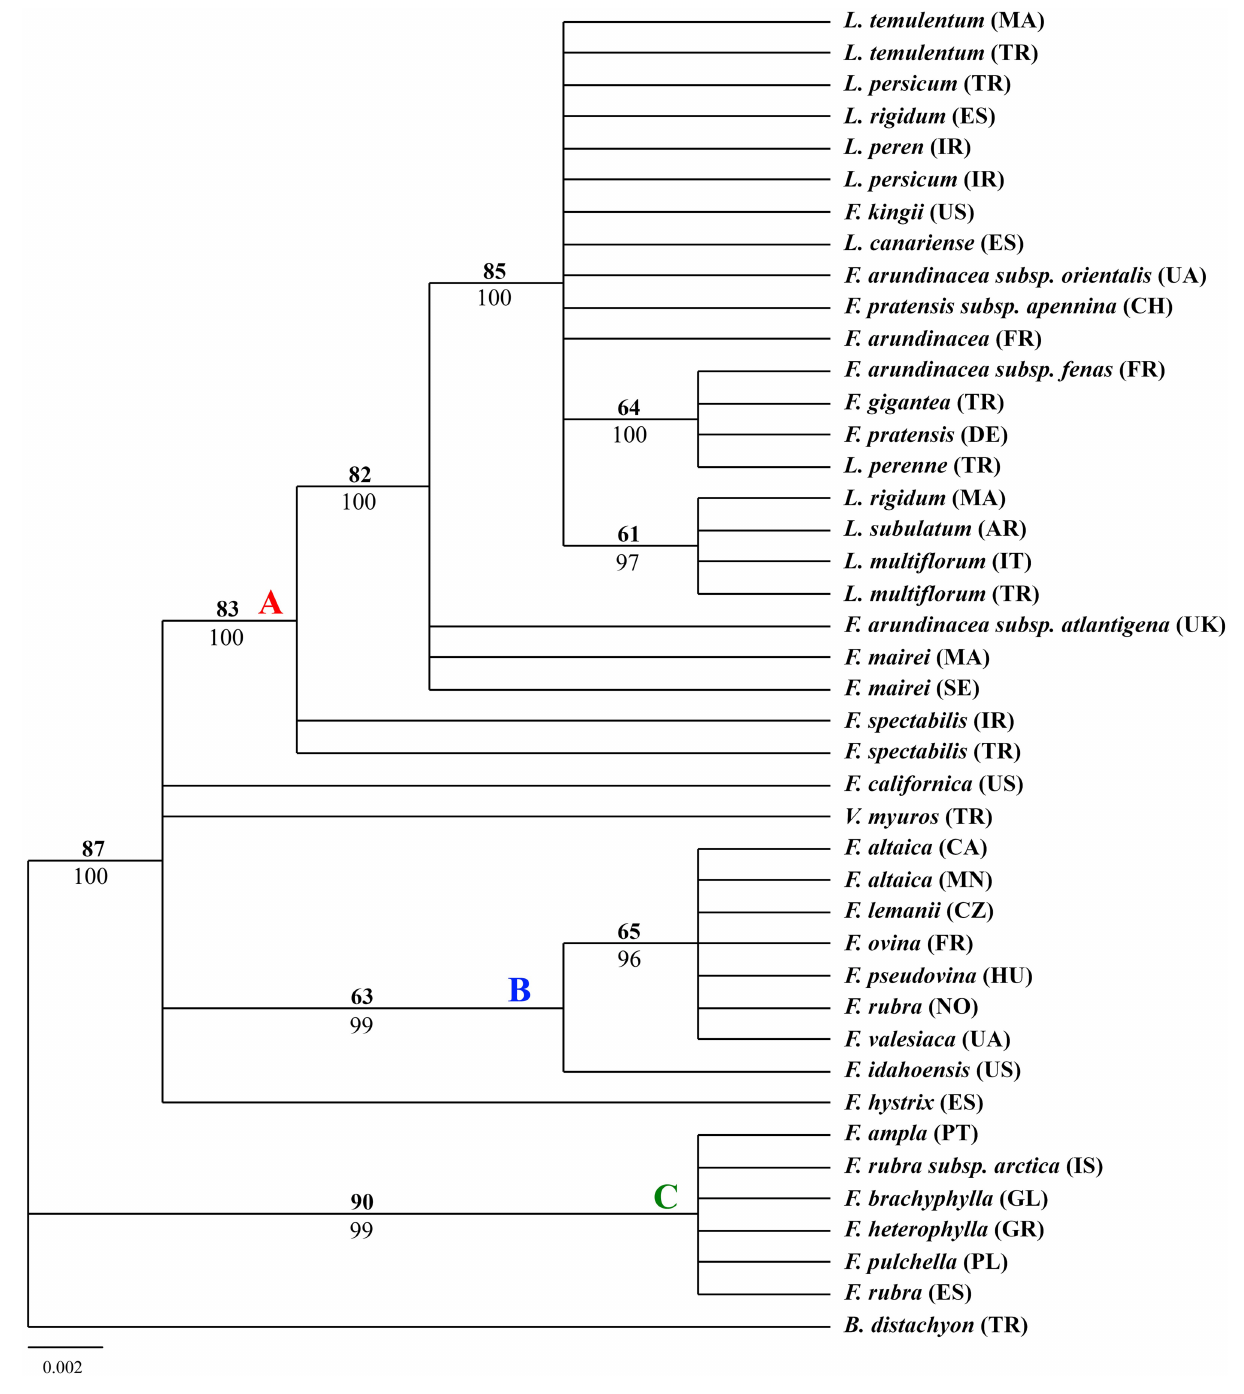
Cytological investigations at the Institute for Biological, Environmental, and Rural Sciences (IBERS) using genomic in situ hybridization (GISH) and as total genomic DNA probes,